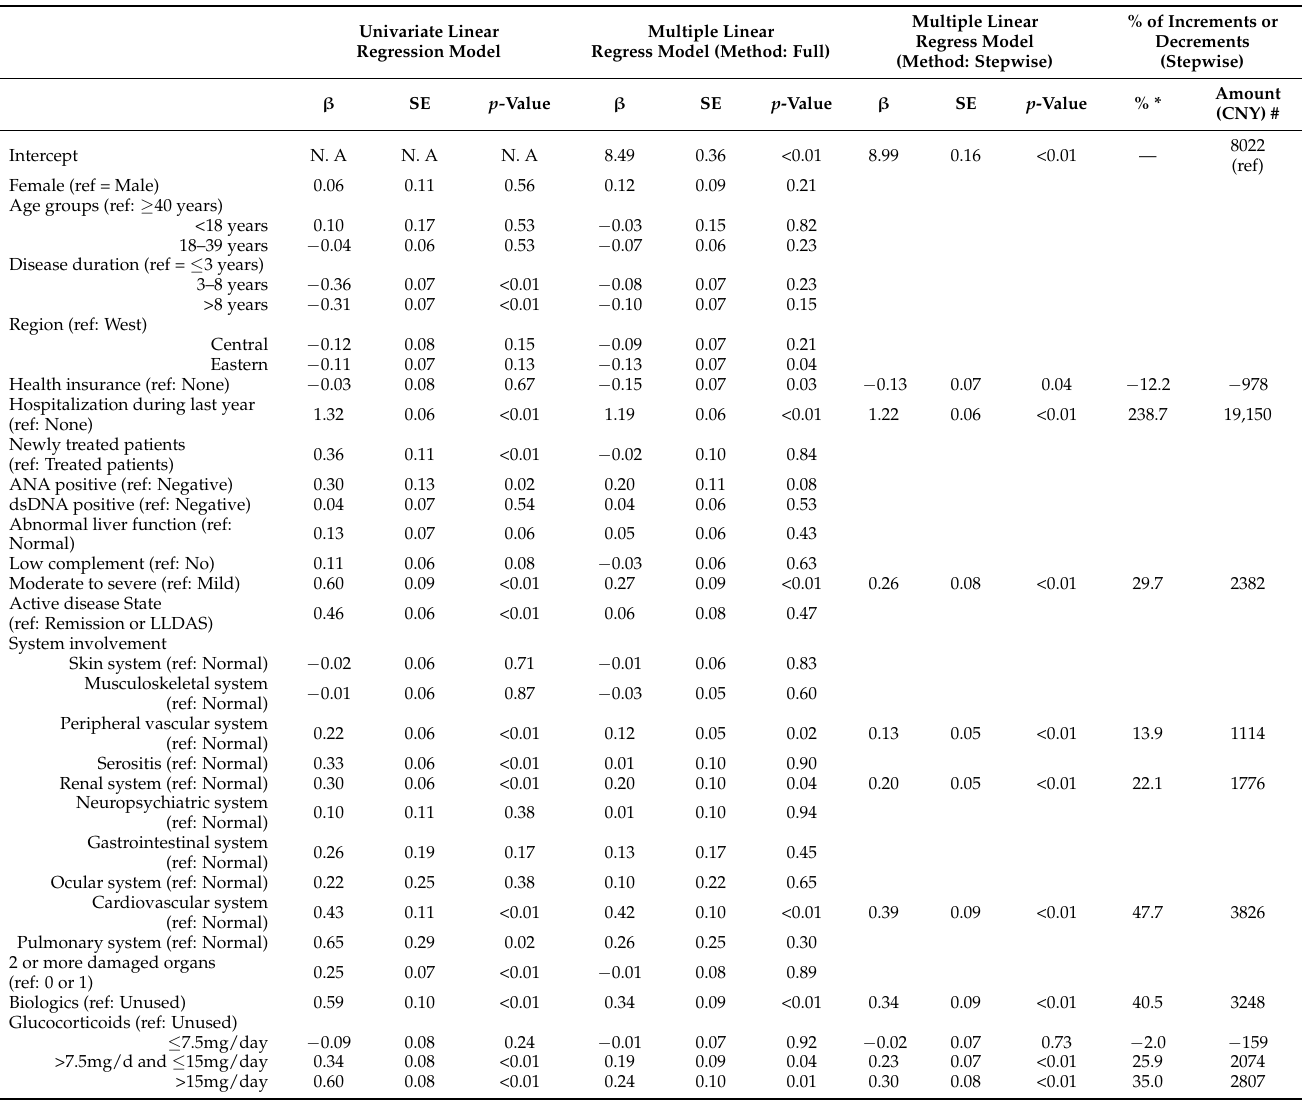
Table 4. Results of the univariate and multiple linear regression models. Univariate Linear Regression